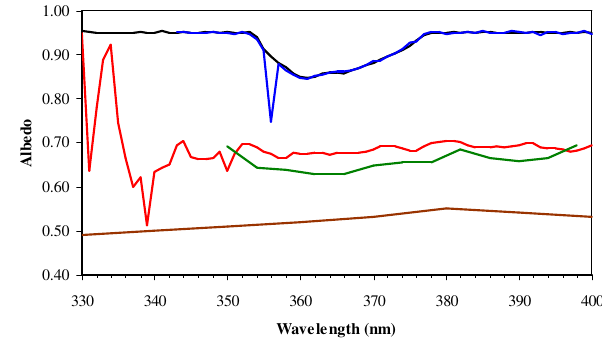
Figure 7. Spectral dependence of the snow albedo under different snow and sky conditions. The blue and aqua (fresh snow) lines: at the Arctic drift station in 1979. The cornflower line: at the Arctic drift station in 1979 under cloudy sky. The cyan line: at the Arctic drift station in 1979 for wet snow under cloudy sky. The dark green line: at Ladoga on 28 April 1985 (wet snow). The green line: at Ladoga on 29 April 1985 (wet snow). The brown line: at Ladoga on the cloudy day of 20 April 1985 (wet snow).